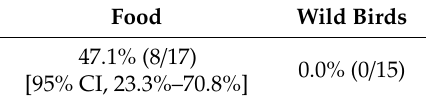
Table 2. Percentage of Salmonella isolates from food and wild birds resistant to at least one antimicrobial.